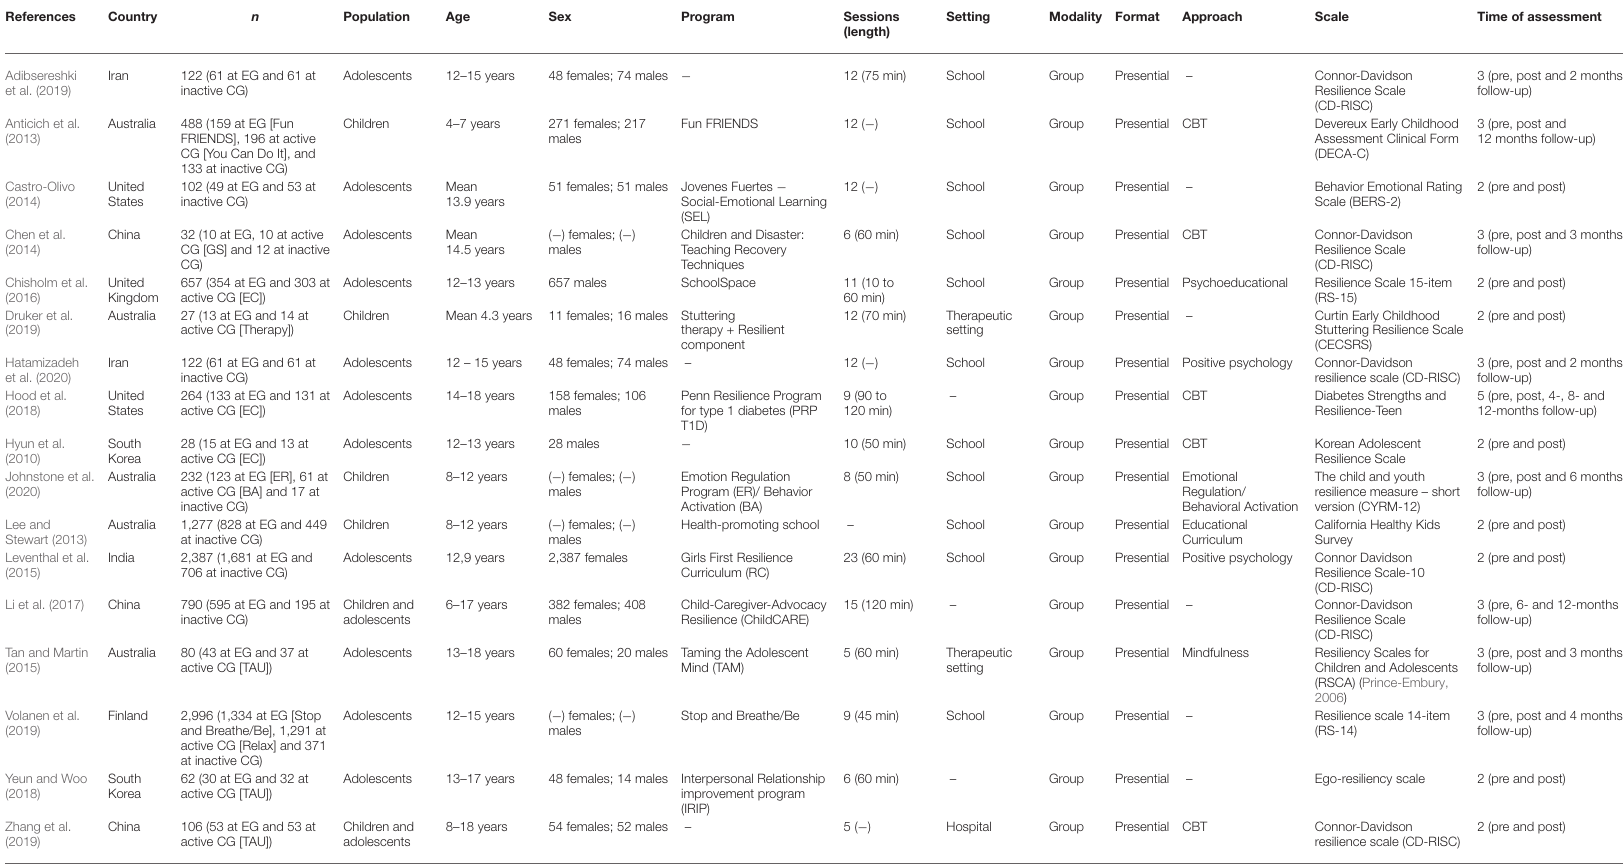
TABLE 1 | Characteristics of included studies.